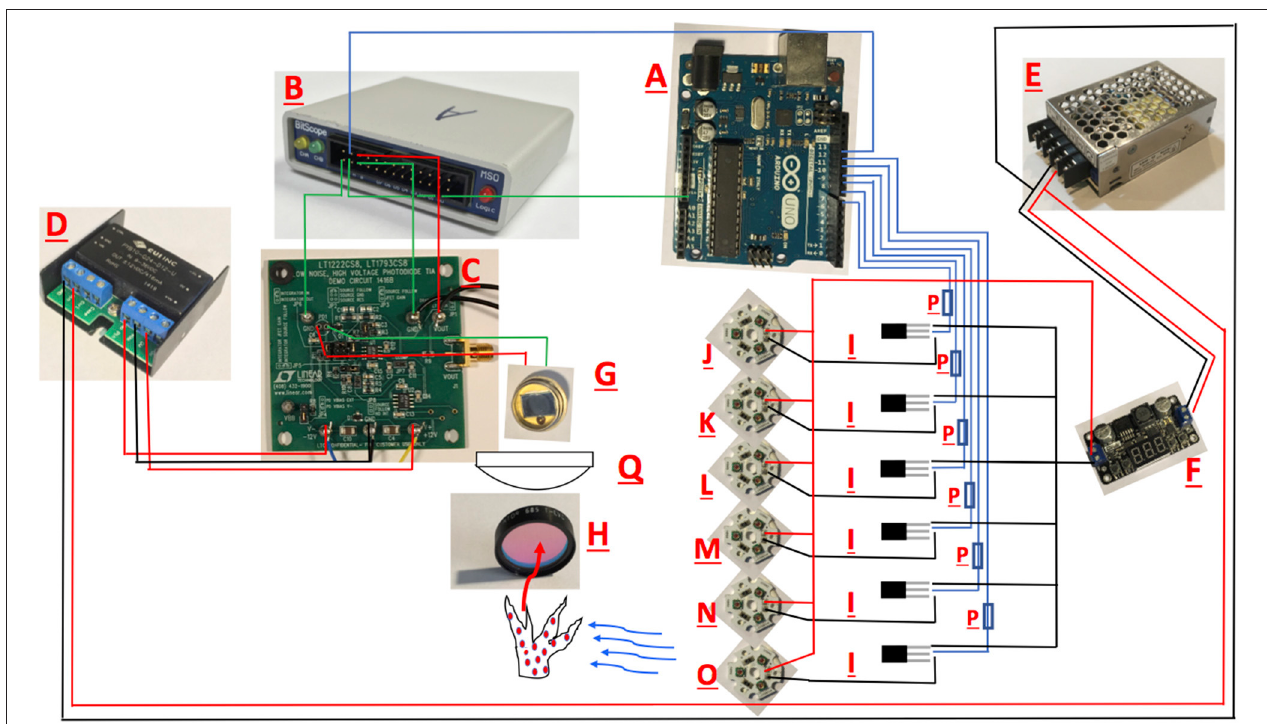
FIGURE 1 | Schematic for the open source multispectral fluorometer. Names of Individual parts are listed in Table 1 . Black and red lines illustrate wire connections between hardware.